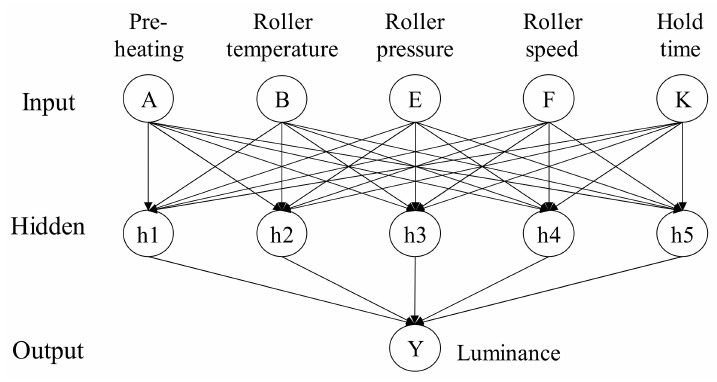
Figure 15. The NN structure for the soft-to-hard lamination